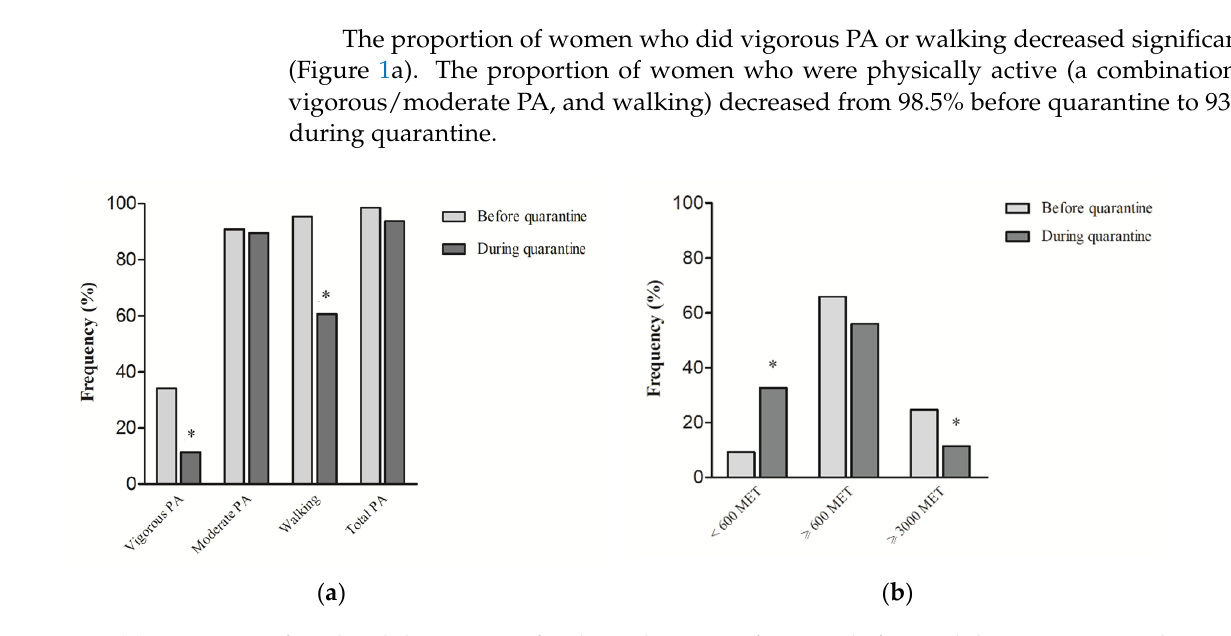
Figure 2. Proportion of self-reported physical activity modality of women before and during COVID-19 home confinement.